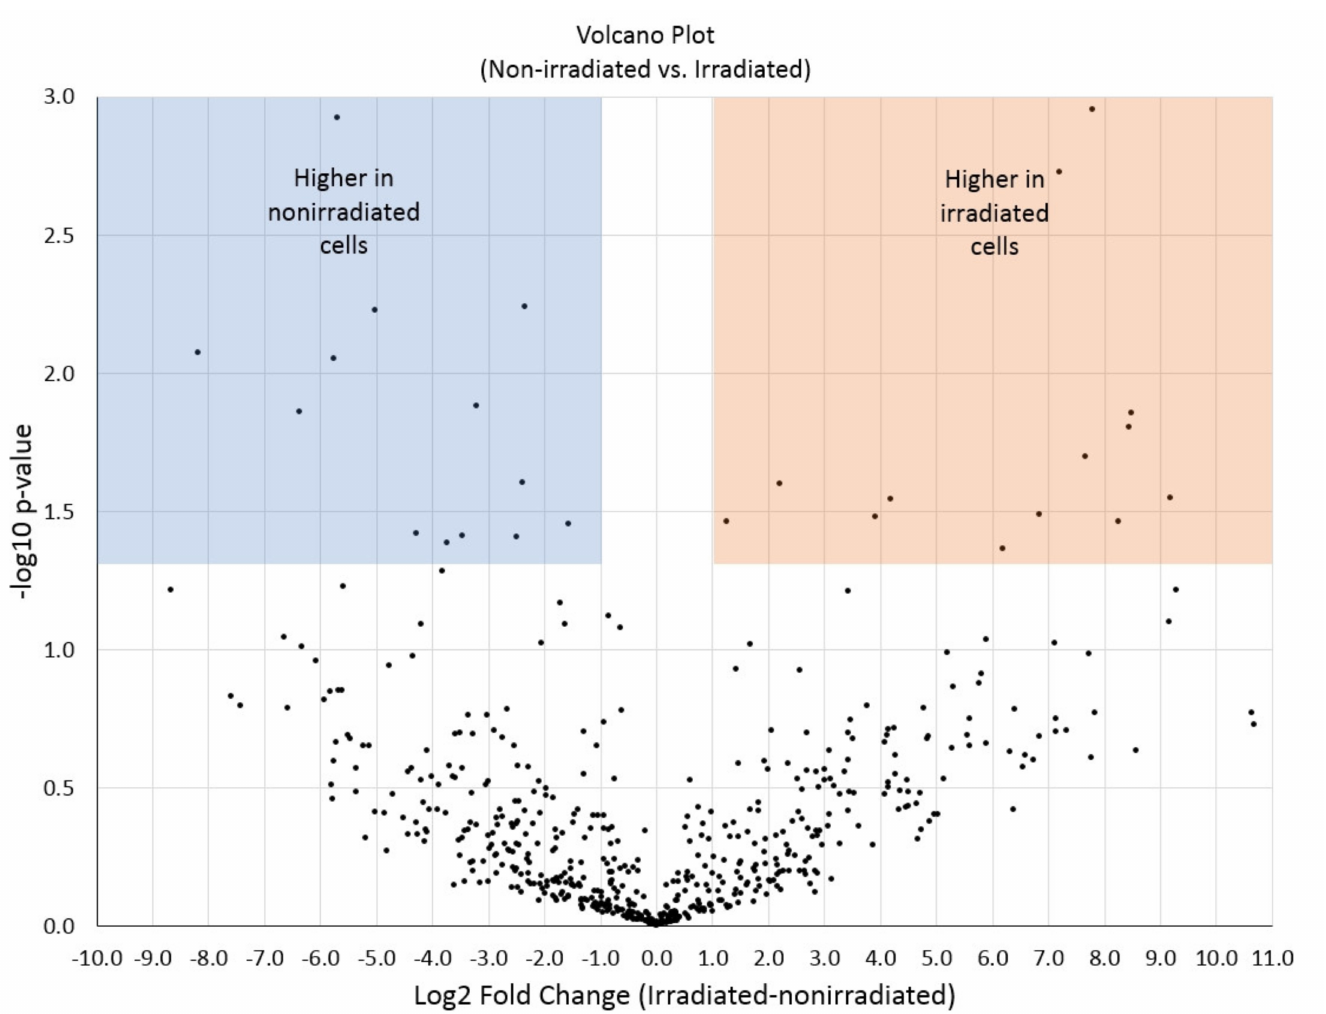
Figure 5. Volcano plot summarizing the proteomic results obtained from microvascular microfluidic lumen samples exposed to Co-60 γ radiation versus nonirradiated controls. Ultra-performance liquid chromatography (UPLC)-driven nanoelectrospray high-resolution tandem mass spectrometry and human proteome database analysis derived 26 statistically significant proteins that change in abundance between irradiated and nonirradiated tissue chip platforms (blue and orange boxed